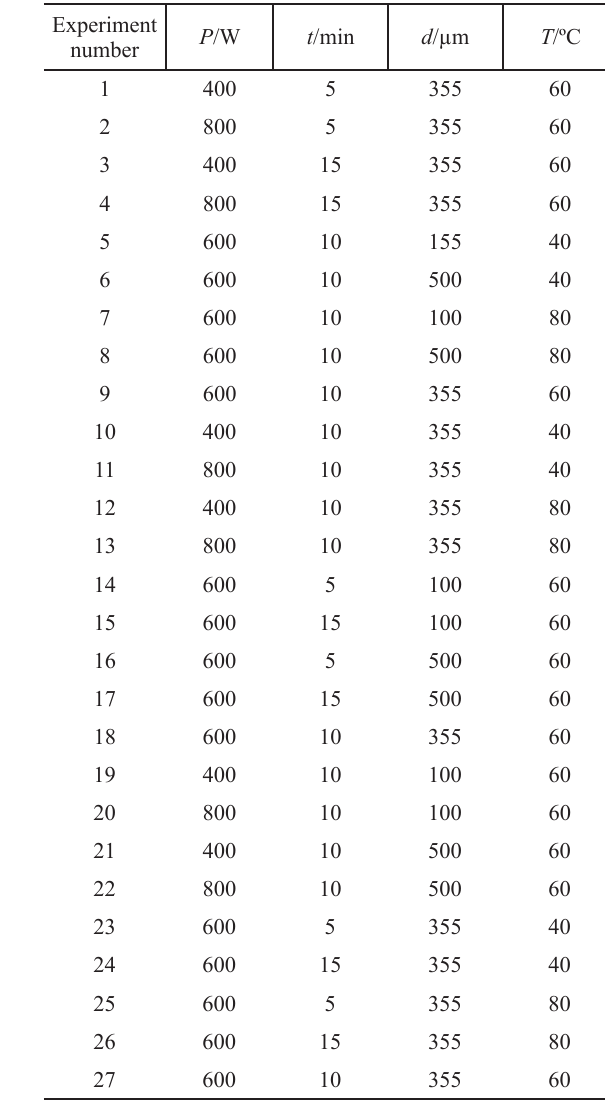
Table 1 – Experimental conditions for the conventional aqueous extraction